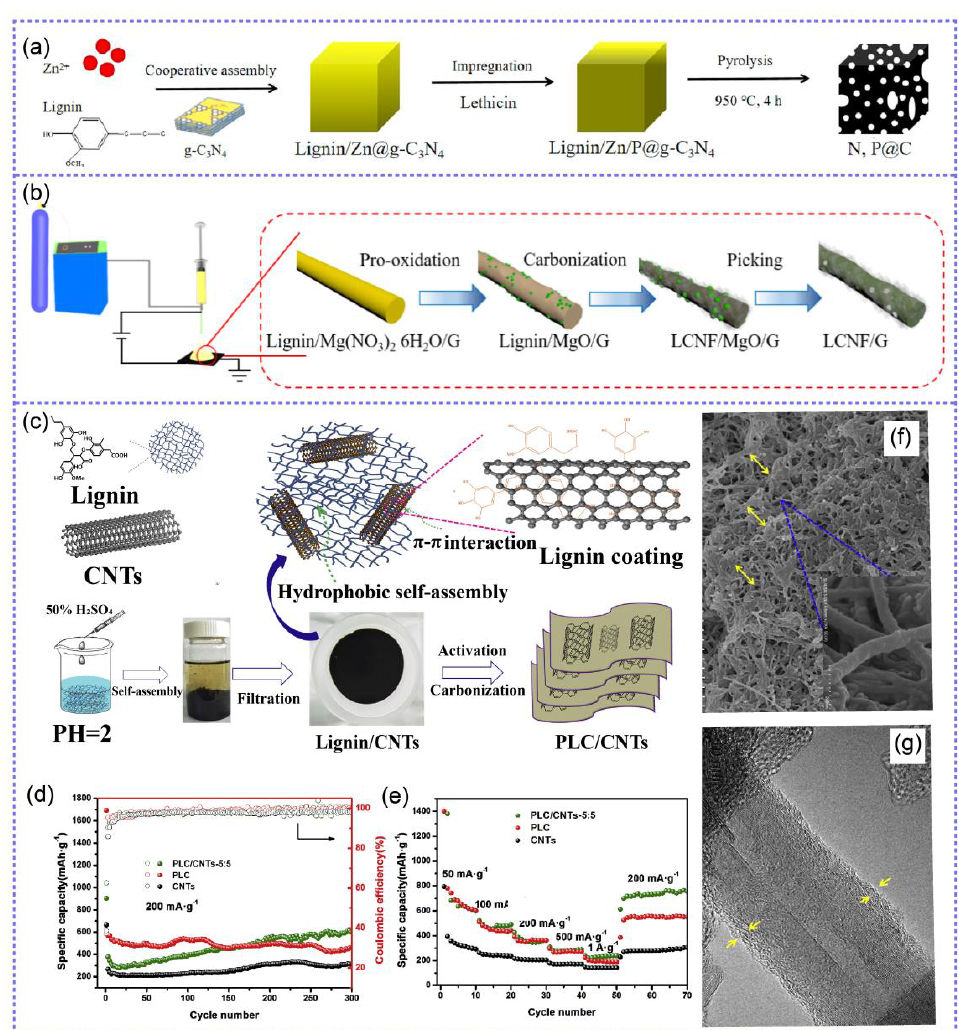
Figure 3. ( a ) Synthesis of lignin/Zn@g-C3N4 and N, P@C. ( b ) Preparation route and electrochemical performance of LCNF/G. ( c ) The fabrication processes of PLC/CNTs. The GCD curves ( d ) and rate performance ( e ) of CNTs, PLC and PLC/CNTs-5:5. ( f ) The SEM image and local high resolution SEM image of PLC/CNTs-5:5 (layer structure shown as yellow arrows). ( g ) The TEM of PLC/CNTs-5:5 (PLC is tightly wrapped around carbon nanotubes shown as yellow arrows). (From Refs.